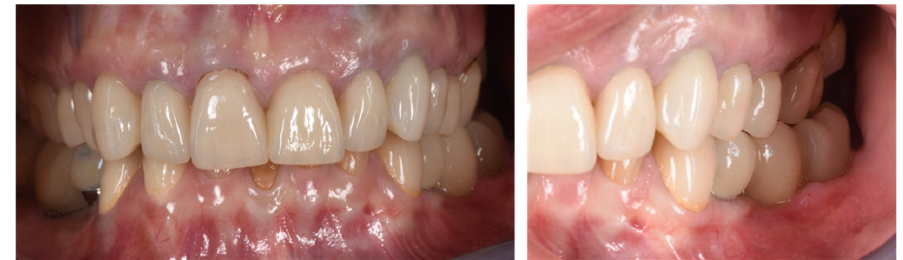
Figure 10. Clinical evaluation after 18 months of prosthetic loading.